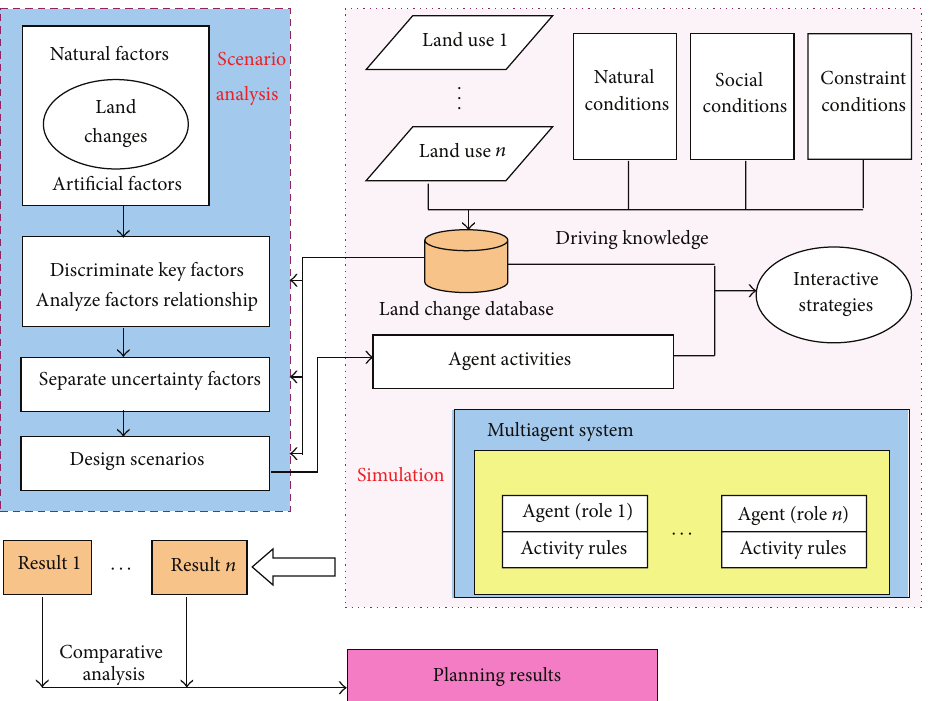
Figure 1: The theoretical framework of landscape planning based on MAS and SA